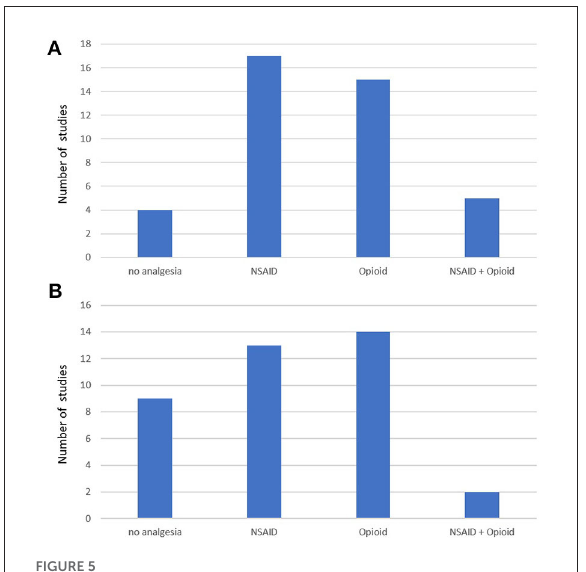
FIGURE5 Type of analgesia in mice (k = 39 studies) and rats (k = 36 studies) combined for grimace, nest building and burrowing. (A) Type of analgesia used in mice. (B) Type of analgesia used in